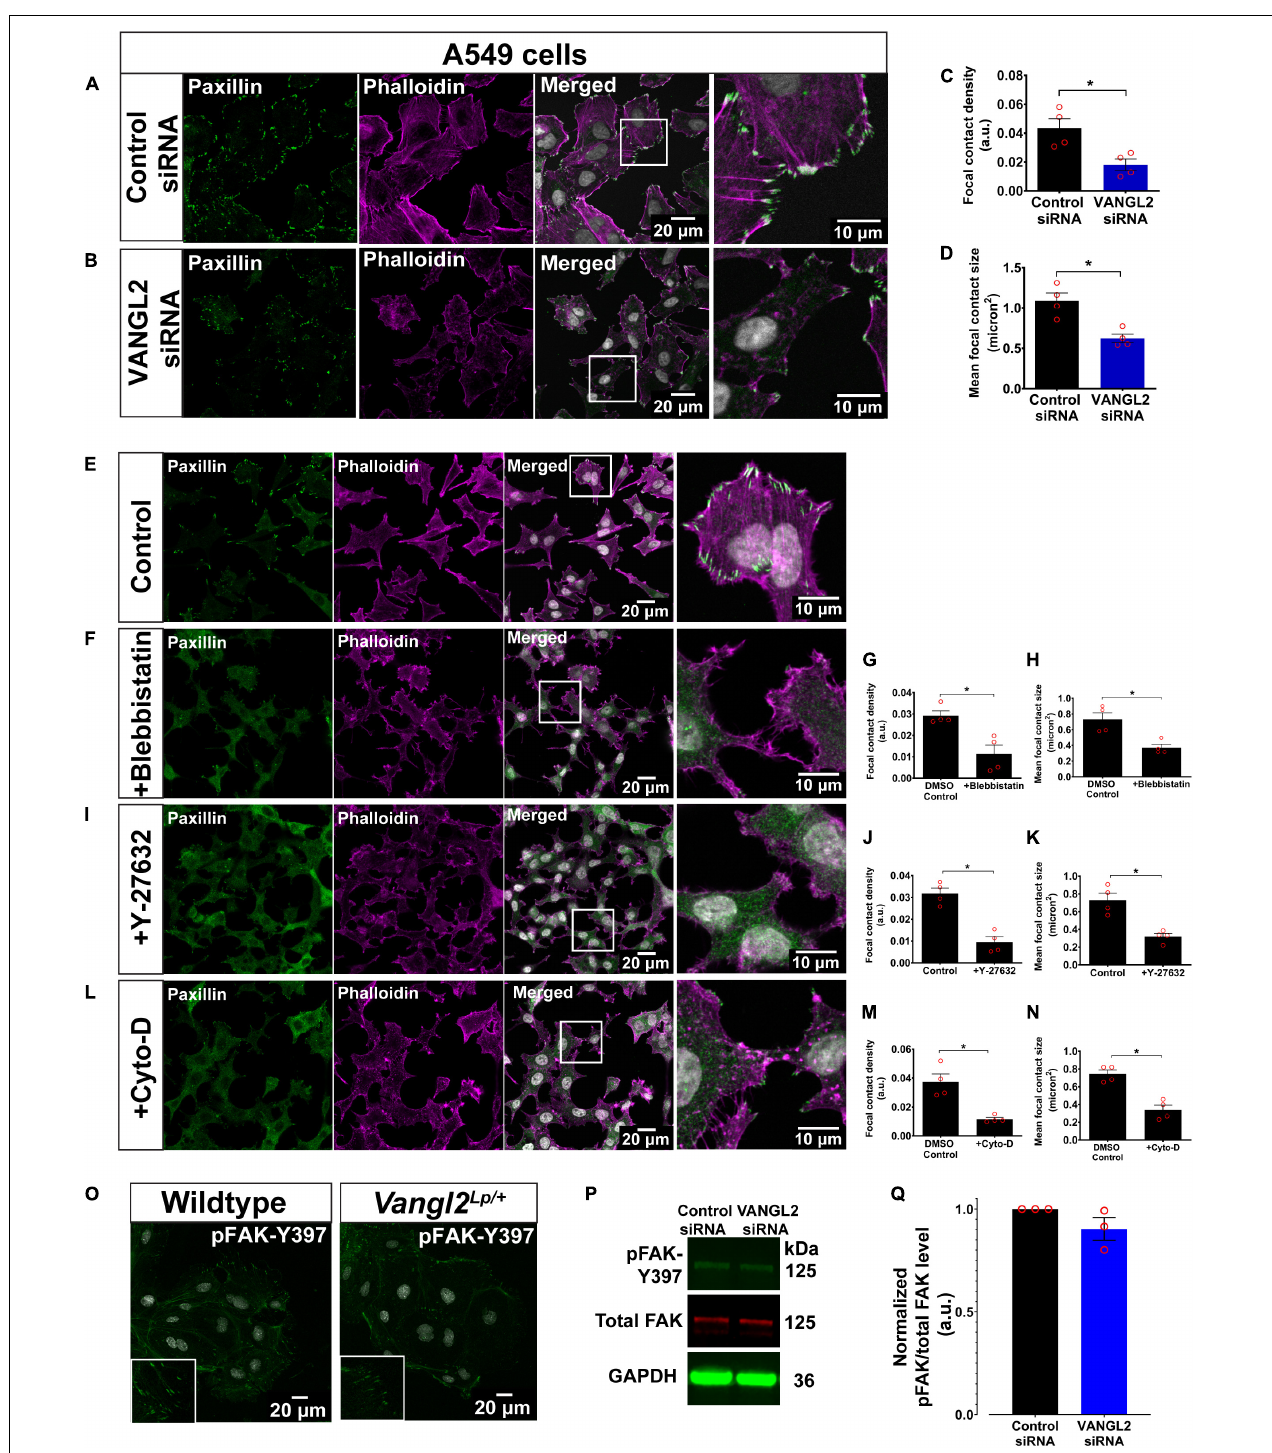
FIGURE 4 | A549 treated with actomyosin inhibitors phenocopy actin cytoskeleton and focal adhesion aberrations following siRNA knockdown of VANGL2 . Representative images showing A549 transfected with (A) control siRNA or (B) VANGL2 siRNA. A549 labeled with phalloidin (magenta) to visualize F-actin and paxillin (green) for focal contacts. Nuclei were stained with DAPI (gray). Quantification of focal contact density (C) and mean focal contact size (micron 2 ) (D) in control siRNA- or VANGL2 siRNA-treated A549 cells. n = 4 independent experiments; two technical replicates for each group per experiment; each dot represents mean value per experiment. Mann–Whitney U -test, ∗ p < 0.05. Representative images showing control A549 without treatment (E) , A549 treated with 25 µ M blebbistastin